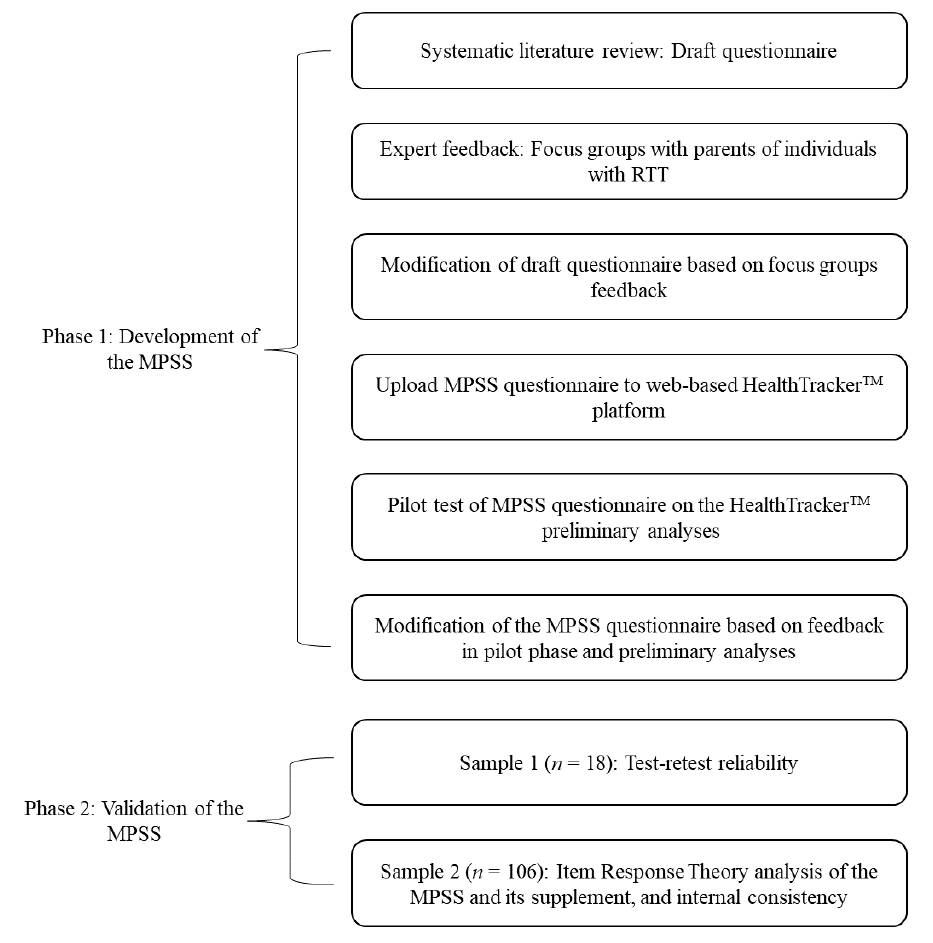
Figure 1. General overview of the development and validation of the Multi-System Profile of Symptoms Scale (MPSS) in patients with RTT.